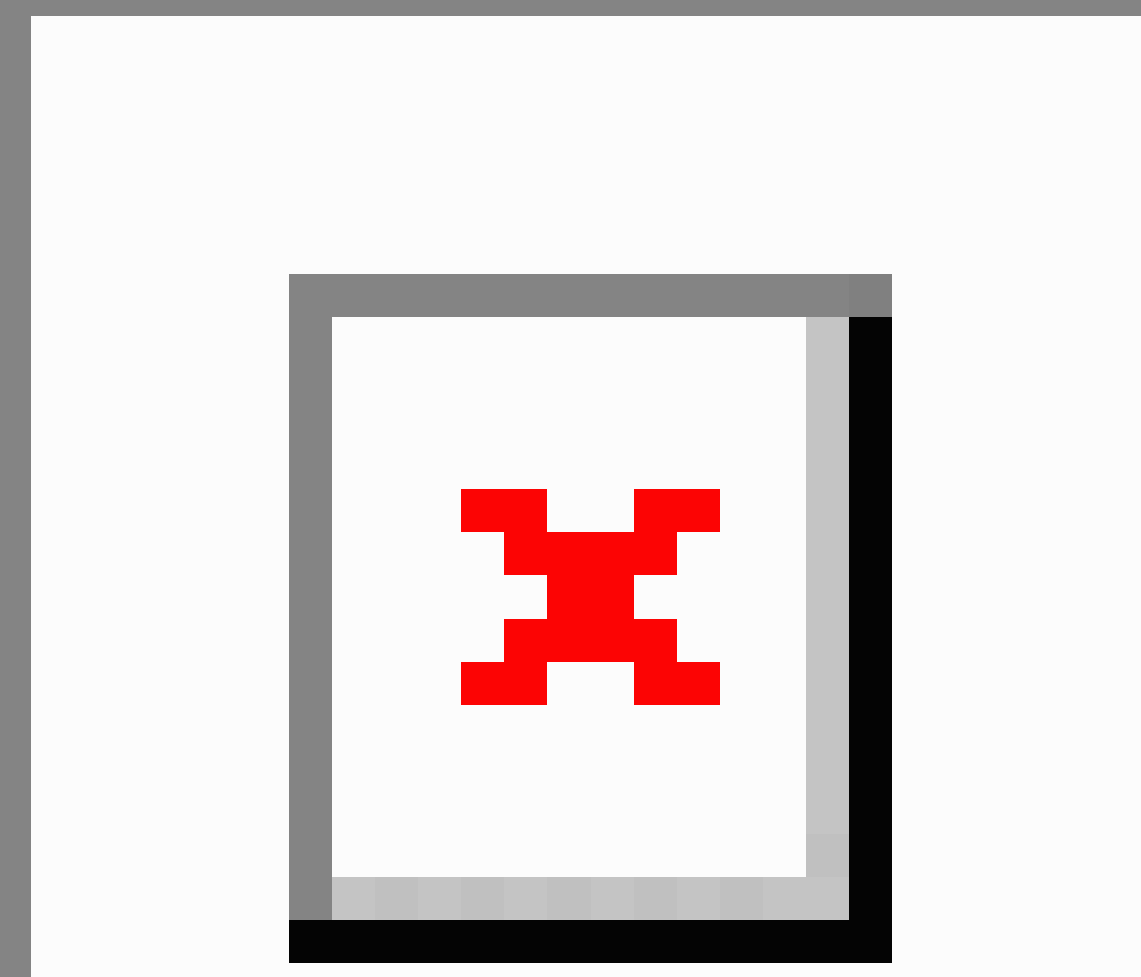
Figure 3. Weekly ratings of depressive symptoms (MADRS-S, maximum score is 54 points), symptoms of (hypo)mania (AS-18, maximum score for mania section is 36), and insomnia (ISI, maximum score is 28 points) for patient 2. The vertical line marks the start of the intervention period. Dashed blue lines indicate the mean level of depressive symptoms (MADRS-S) during the baseline period and the treatment